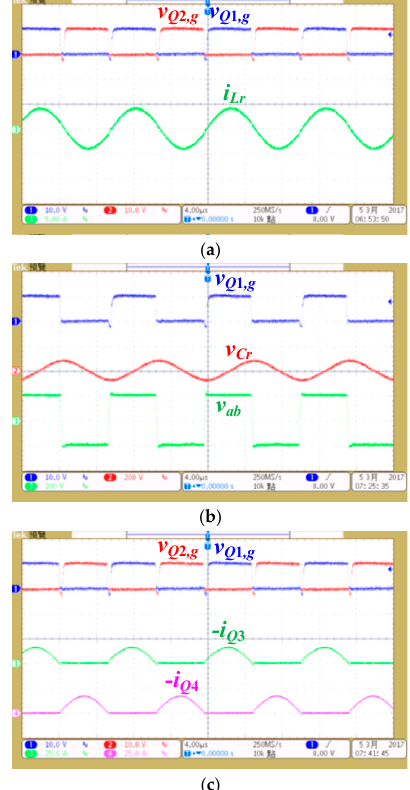
Figure 8. Test results under forward power transfer and full load with V H = 400V ( a ) v Q 1 ,g , v Q 2 ,g and i Lr [ v Q 1 ,g , v Q 2 ,g : 10 V/div; i Lr : 5 A/div; time: 4 µ s/div] ( b ) v Q 1 ,g , v Cr and v ab [ v Q 1 ,g : 10 V/div; v Cr , v ab : 200 V/div; time: 4 µ s/div] (c) v Q 1 ,g , v Q 2 ,g , − i Q 3 and − i Q 4 [ v Q 1 ,g , v Q 2 ,g : 10 V/div; − i Q 3 , − i Q 4 ,g : 25 A/div; time: 4 µ s/div].